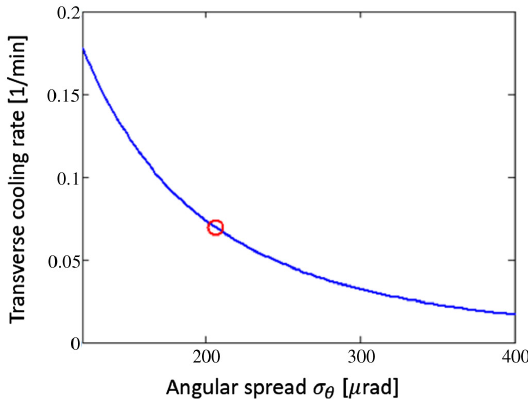
FIG. 9. The rms cooling rate depending on the average angular spread of the electron bunch. The circle represents the exper- imentally achieved cooling